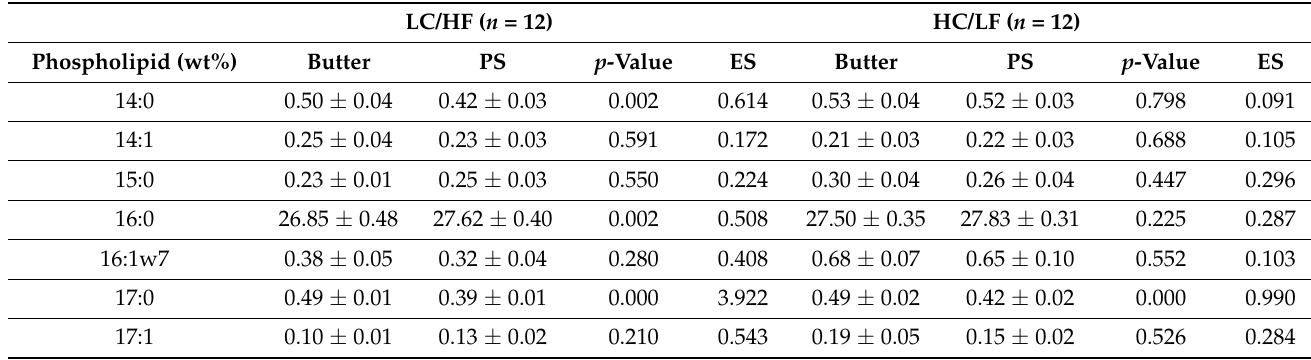
Table 5. Butter versus Palm Stearin (PS) Diet plasma phospholipid fatty acid responses in the low-carbohydrate/high-fat (LC/HF) and high-carbohydrate/low-fat (HC/LF) groups. LC/HF ( n = 12) Phospholipid